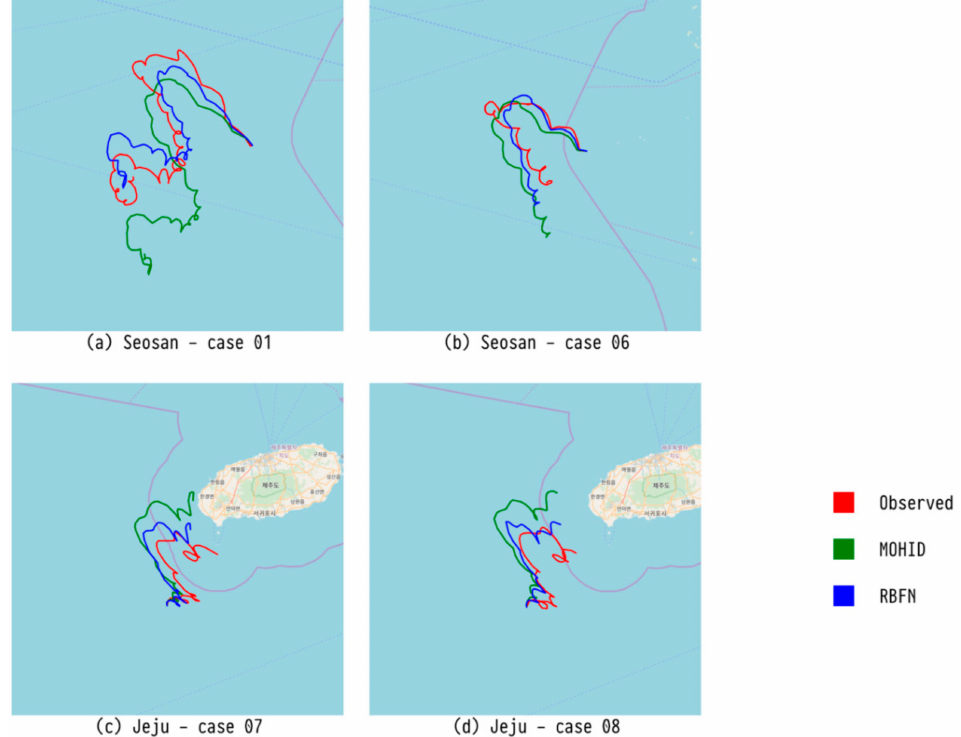
Figure 10. Comparison of trajectory predicted by our RBFN model, trajectory predicted by an existing numerical model (MOHID), and observed trajectory for four major